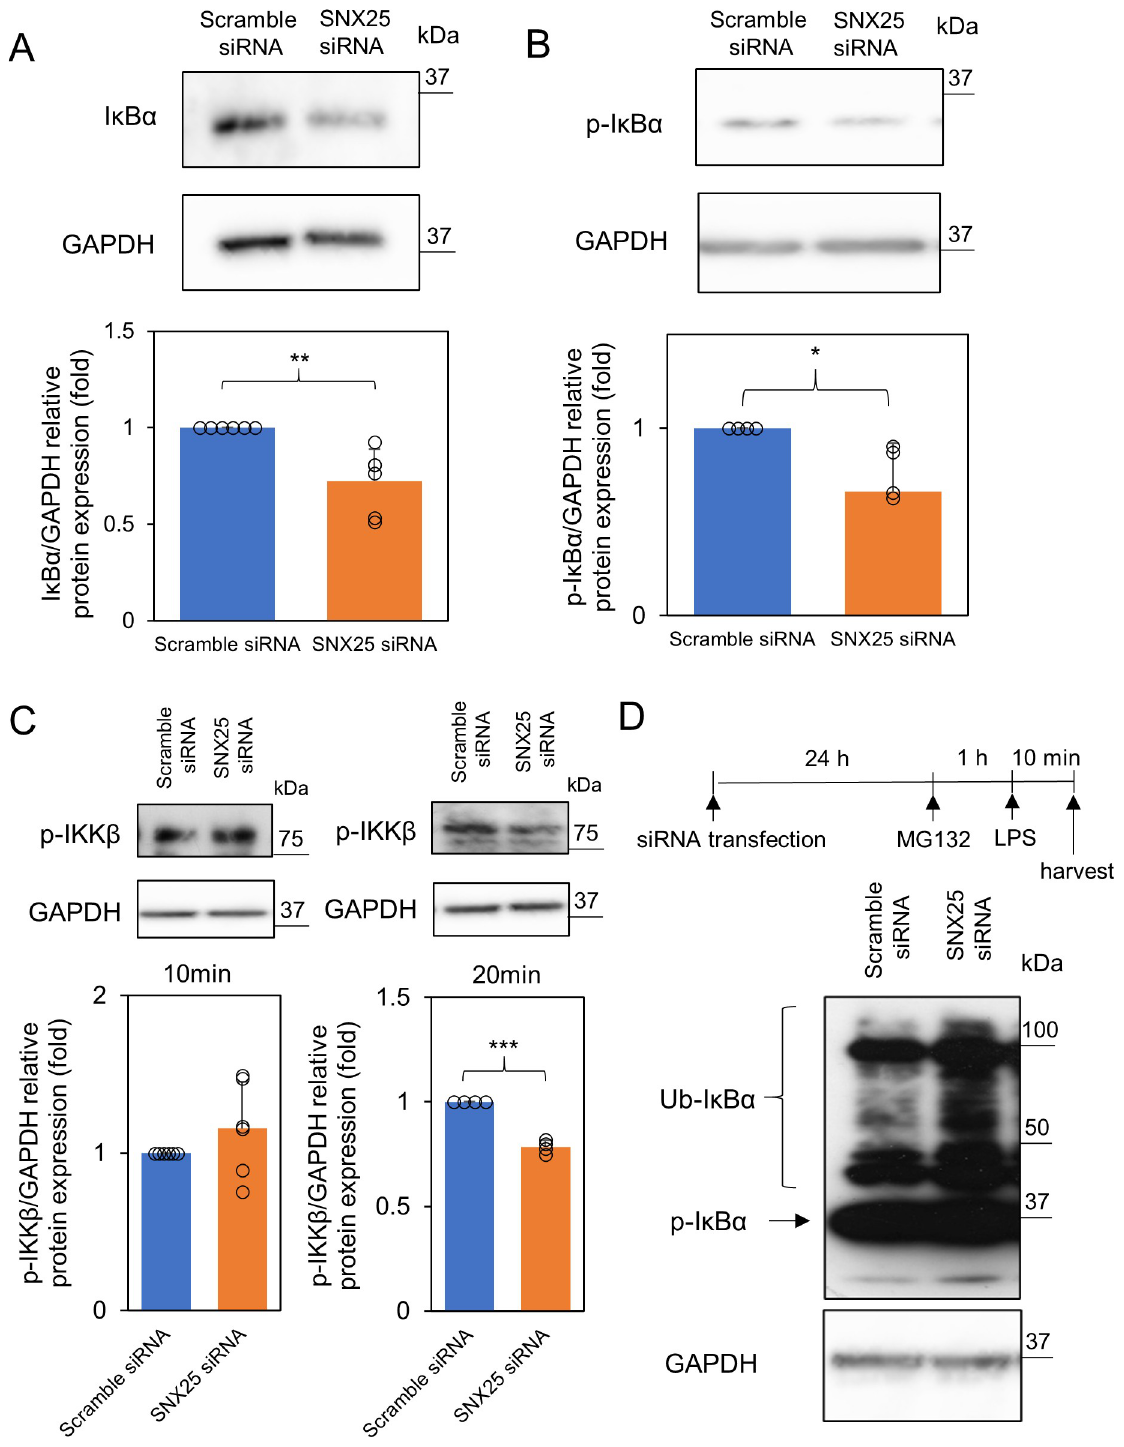
Fig 5. Activation of I κ B α and IKK β in SNX25 knockdown RAW 264.7 cells. (A and B) RAW 264.7 cells were stimulated with LPS (1 μ g/ ml). Expression of I κ B α and p-I κ B α was analyzed by Western blotting. GAPDH was used as a loading control. Data are expressed as means ± SD. Circles indicate the individual experimental values. � P < 0.05 �� P < 0.01, n = 4 (p-I κ B α ) n = 6 (I κ B α ). (C) RAW 264.7 cells were stimulated with LPS (1 μ g/ml). Expression of p-IKK β was analyzed by Western blotting. GAPDH was used as a loading control. Data are expressed as means ± SD. Circles indicate the individual experimental values. ��� P < 0.001, n = 4. (D) MG132-induced accumulation of polyubiquitinated I κ B α was analyzed by Western blotting. GAPDH was used as a loading control.